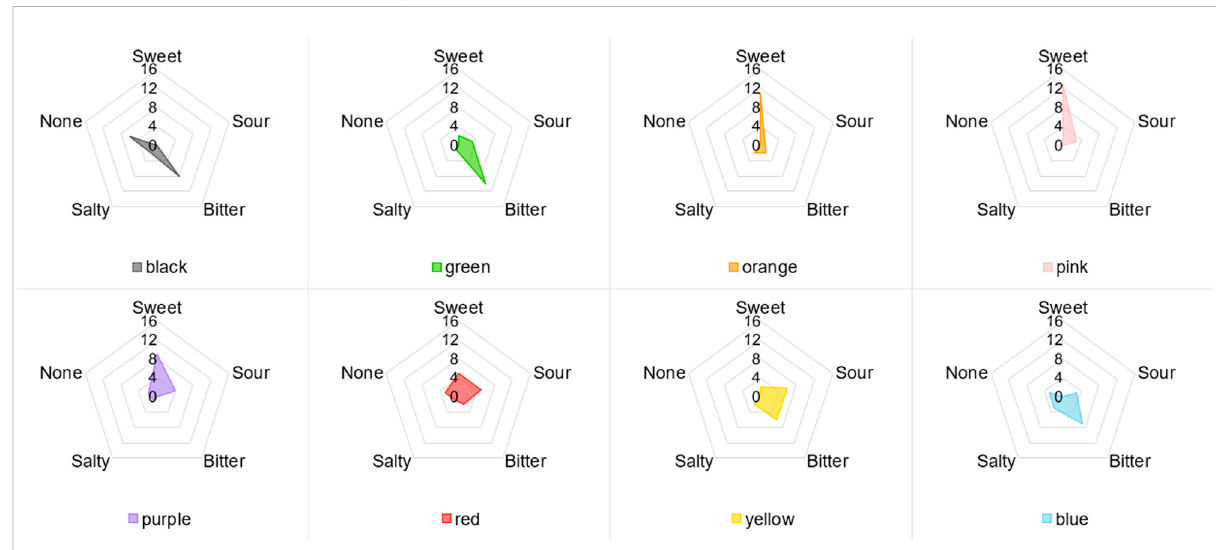
FIGURE 8 Thefrequenciesandpairwisecomparisonsoftheanswersto Q2-2 inExperiment2.Thecolorsinthe fi gurecorrespondtotheambientcolorsin the virtual envrionmes.